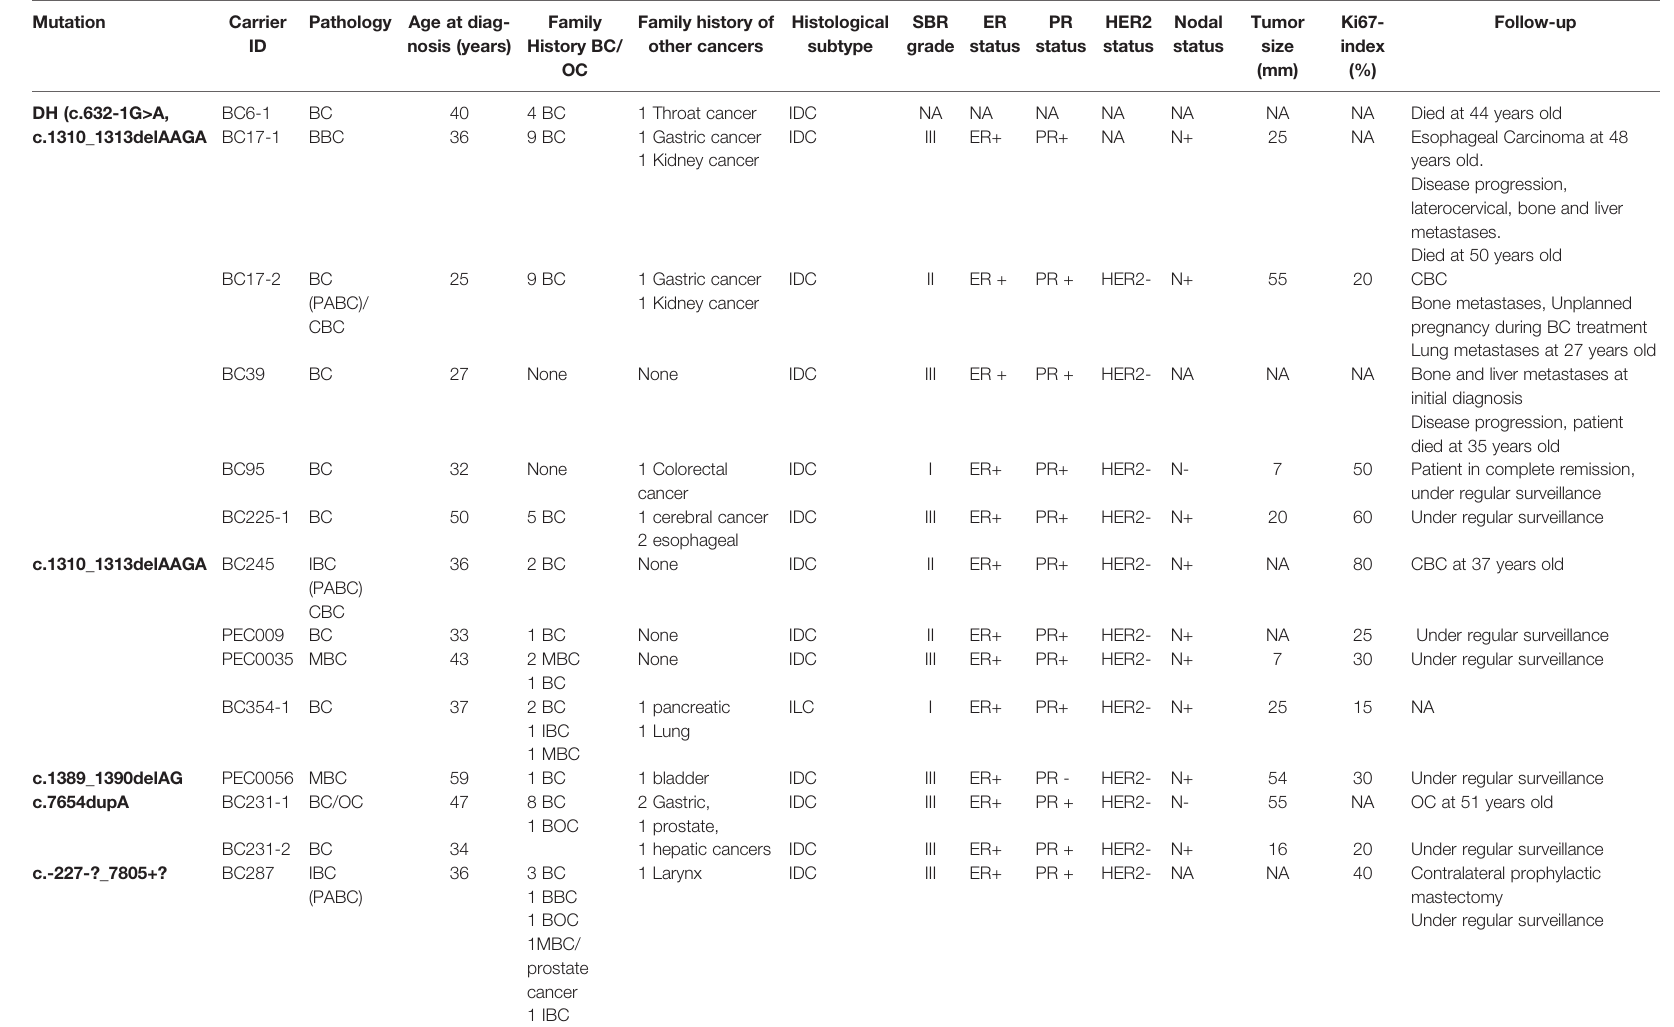
TABLE 3 | Clinico-pathological features of BRCA2